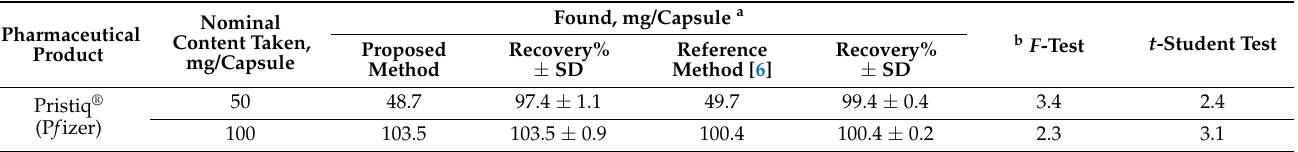
Table 5. ODV determination in its pharmaceutical formulations using C/SWCNTs/MIP-ODV elec- trode.